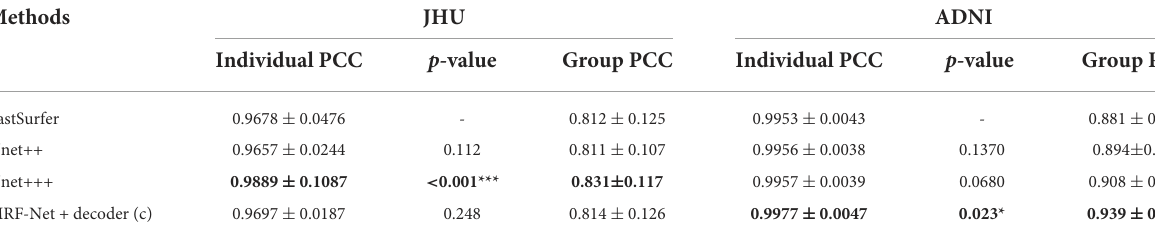
TABLE 6 Estimations of volume on intraclass correlation coefficient (ICC) in terms of individual-level and group-level. Methods